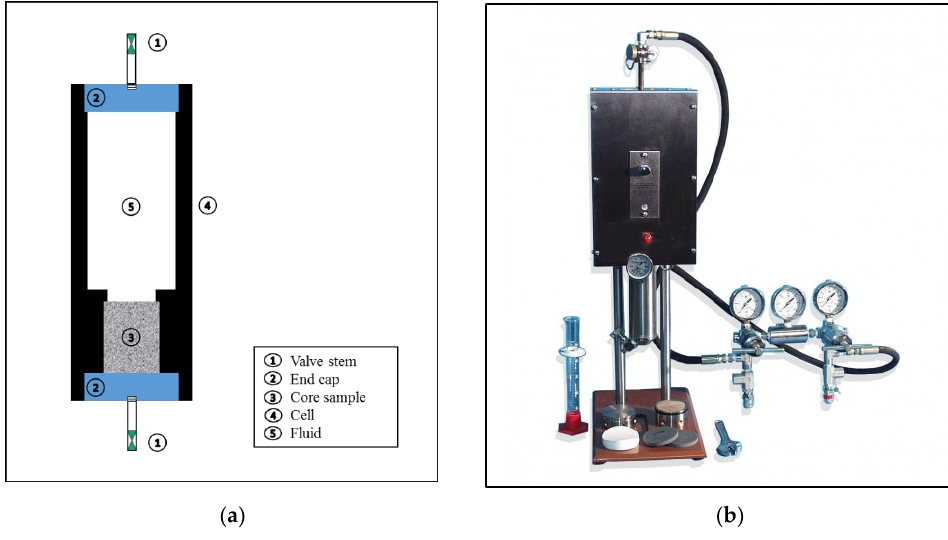
Figure 1. Filtration test equipment: ( a ) Modified filter press cell diagram; ( b ) high-pressure high-temperature (HPHT) filter press.